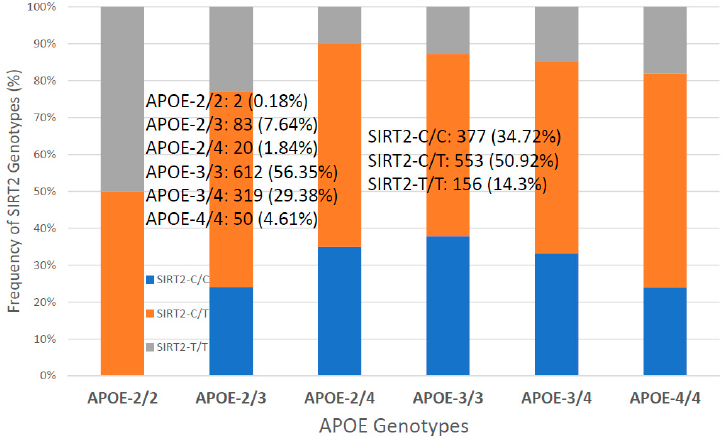
Figure 5. Distribution and frequency of SIRT2 (rs10410544) variants among carriers of major APOE